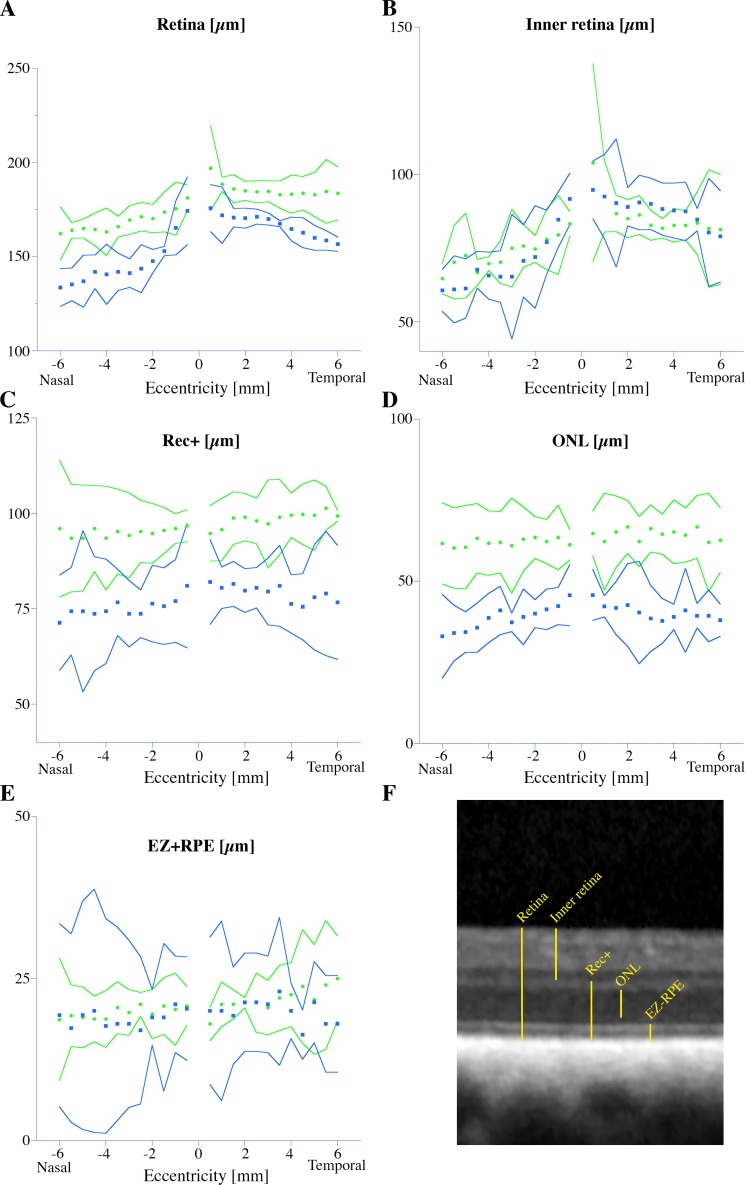
Analysis of retinal layer thickness using OCT.Graphs showing the mean thickness of retinal layers from OCTs of two wild-type dogs at the age of 10- and 12-years (green dots; LAB23 and LAB22, respectively) and two affected dogs at the age of 10- and 12-years (blue squares; LAB10 and LAB16, respectively). The thickness is measured every 0.5 mm from the rim of the optic nerve head (0) along the visual streak. The solid lines indicate 95% confidence intervals. Measurement of the (A) total retinal thickness, (B) inner retina (C) Rec+, (D) ONL and (E) EZ+RPE. (F) The distances presented in the five graphs are shown on the magnified OCT image from a wild-type Labrador retriever dog. OCT = optical coherence tomography; EZ = ellipsoid zone (inner-to-outer segment junction); Rec+ = total photoreceptor length; RPE = retinal pigment epithelium; ONL = outer nuclear layer.